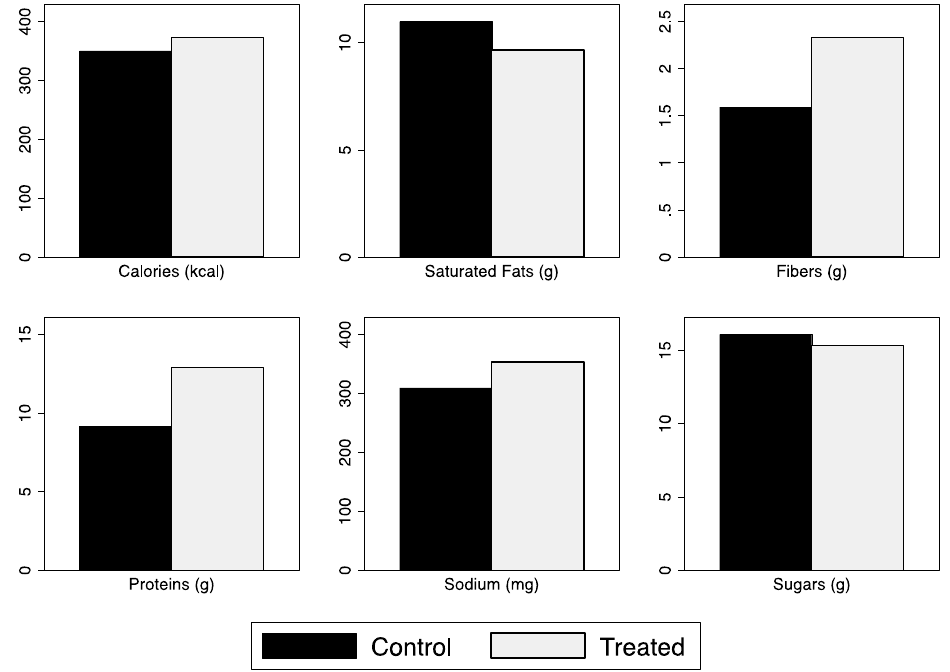
Figure A2. Nutritional content of purchases, by nutrient and randomization group, not standardized serving size.